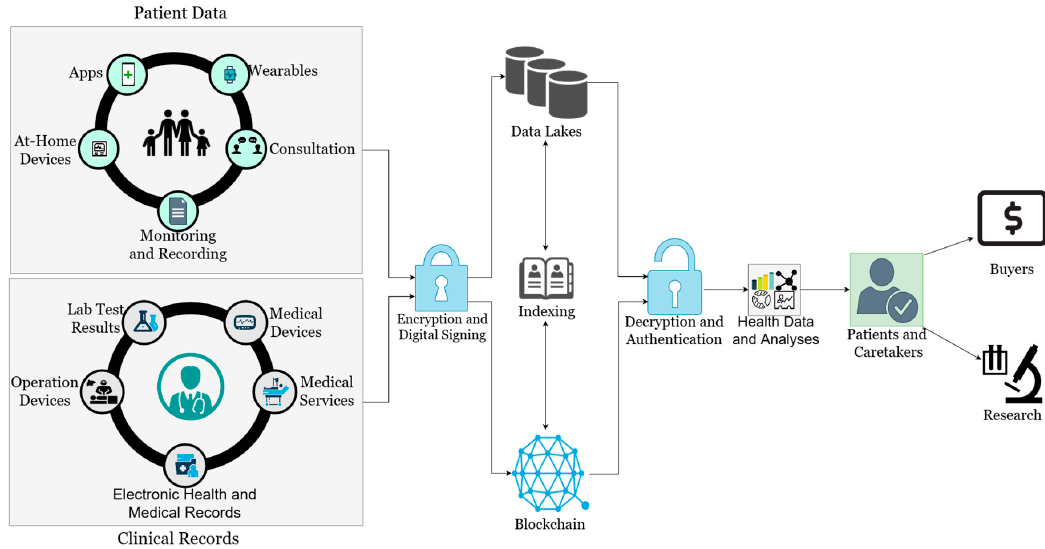
Figure 3. How blockchains can be integrated into personalized medicine.